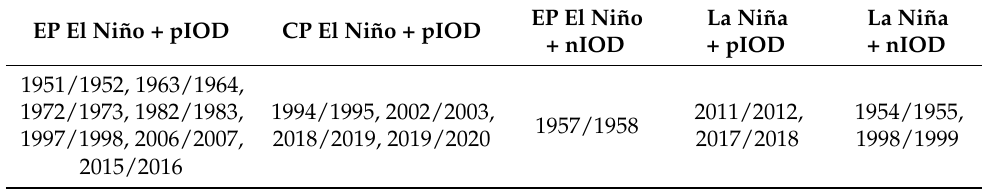
Table 2. All regimes of combined ENSO and IOD events during 1950–2020.